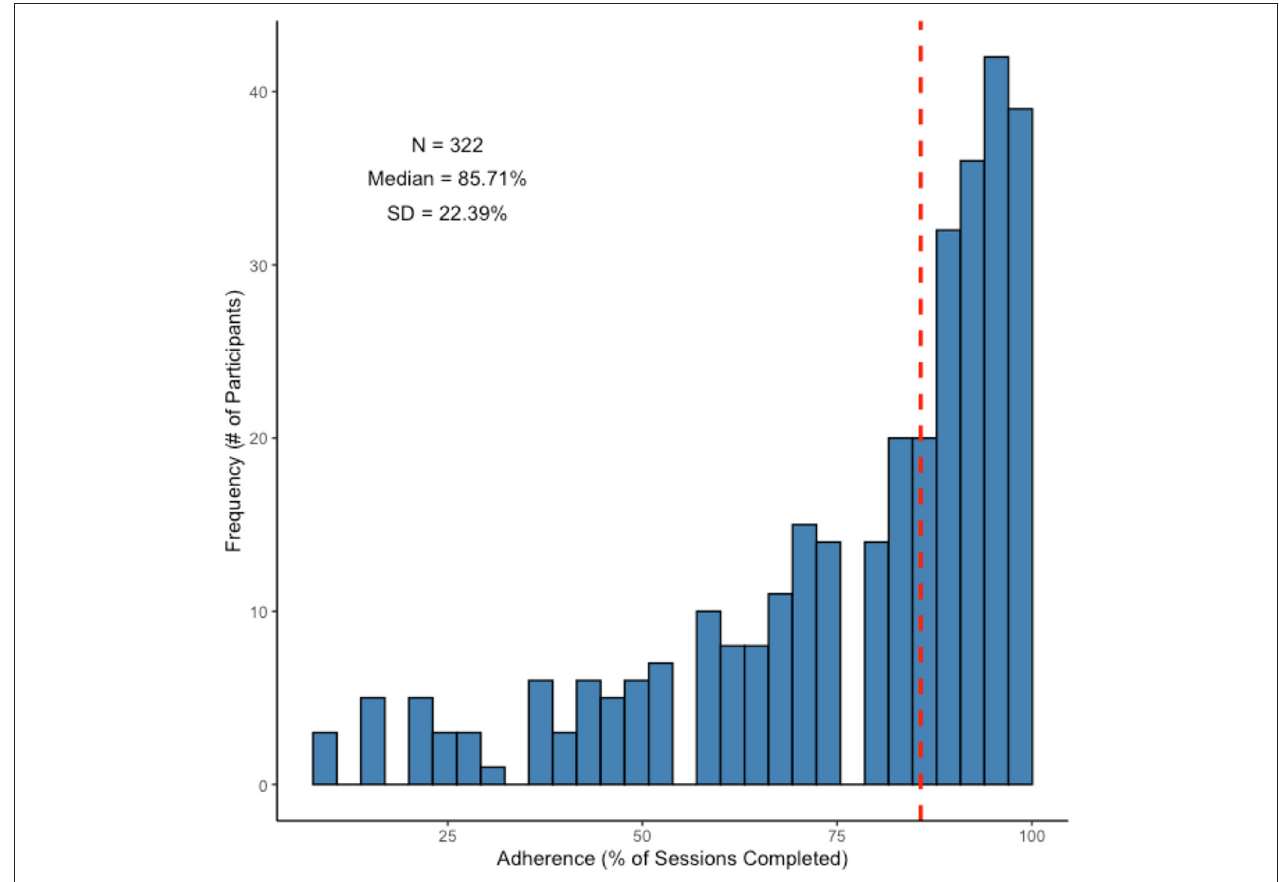
FIGURE 6 | Histogram of adherence rates for participants enrolled in the mobile assessment study. Dashed (red) line indicates the median